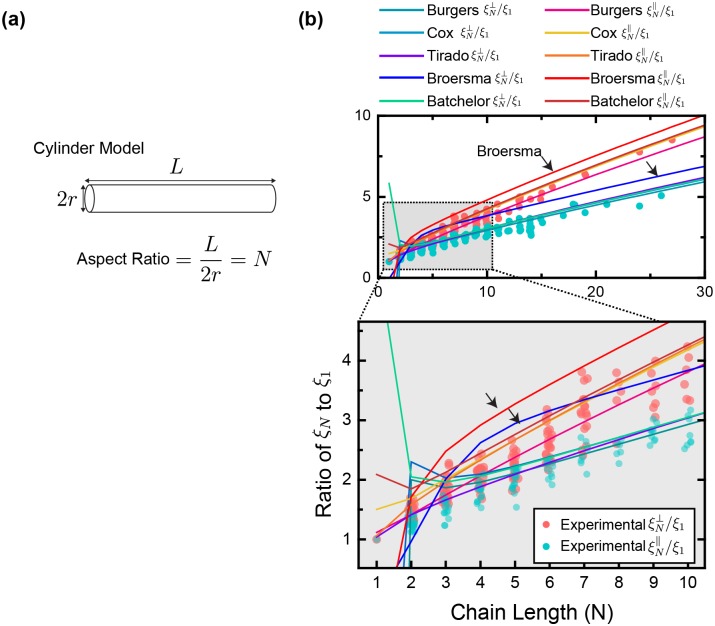
Cylinder model theories and measurements.(a): Schematic of the cylinder model theoretical framework representing rod-like objects. Cylinder model has diameter of 2r and length of L. Chain length in bead model in terms of number of beads N is equivalent to aspect ratio of ellipsoid and cylinder L/(2r). (b): The same experimental data from Fig 5b compared with theoretical curves with various γ from cylinder model as listed in Table 1. Black arrows point to theoretical curves obtained from Broersma [24].